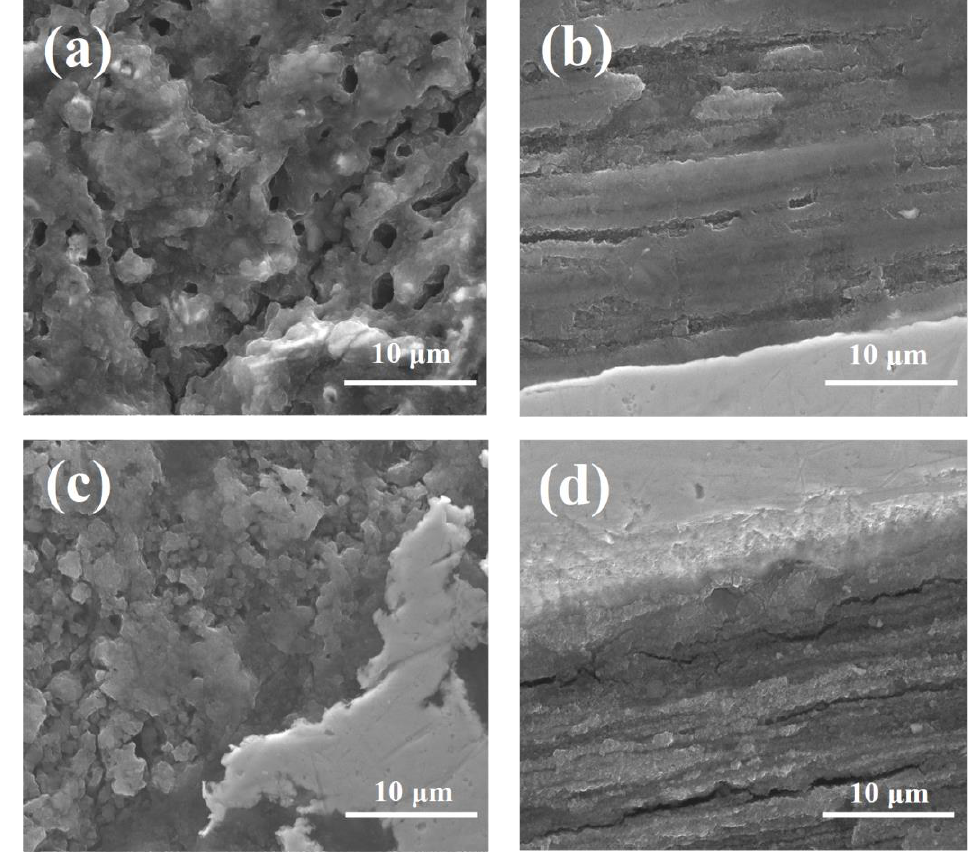
Figure 2. SEM images of 10% SiC-doped MgB 2 wires with a 0.83 mm diameter: ( a ) cross-section and ( b ) longitudinal section for sample E (0.1 MPa and 700 °C) and ( c ) cross-section and ( d ) longitudinal ( b ) longitudinal section for sample E (0.1 MPa and 700 ◦ C) and ( c ) cross-section and ( d ) longitudinal section for sample F (1 GPa and 700 °C). The metal sheath is the Nb barrier. section for sample F (1 GPa and 700 ◦ C). The metal sheath is the Nb